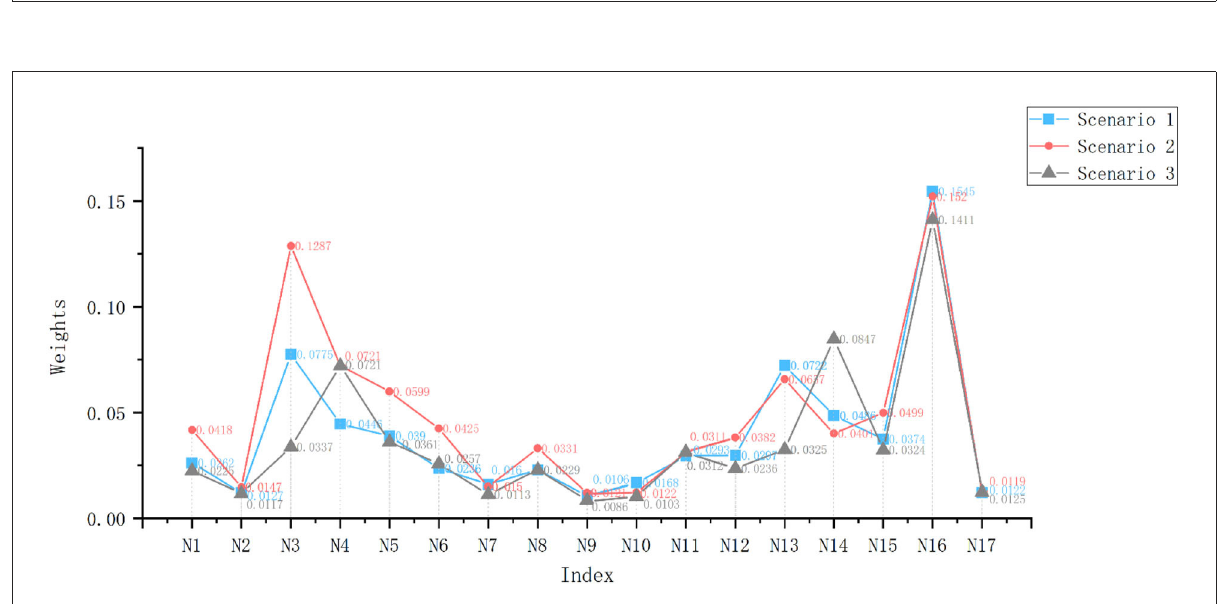
FIGURE6 Weighted standardized decision